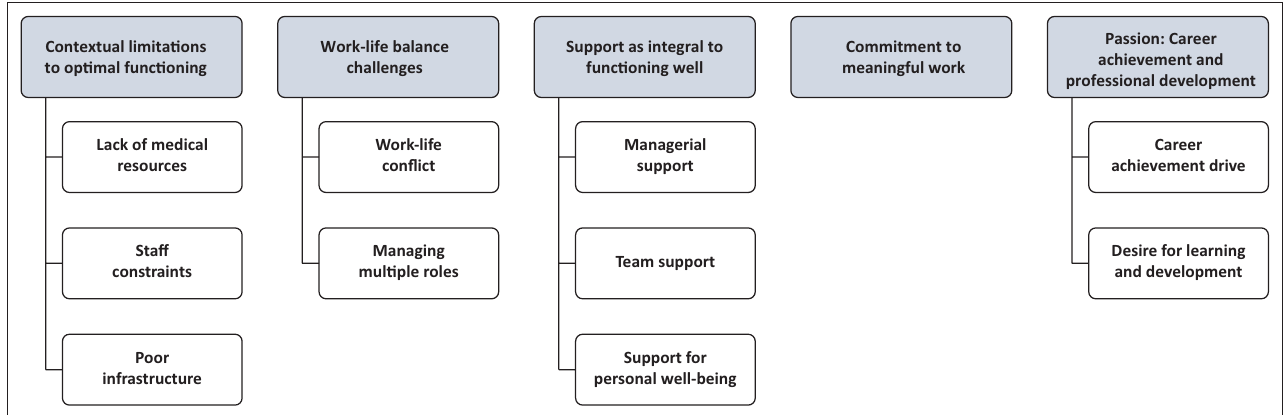
FIGURE 1: Summary of findings: Themes and sub-themes .